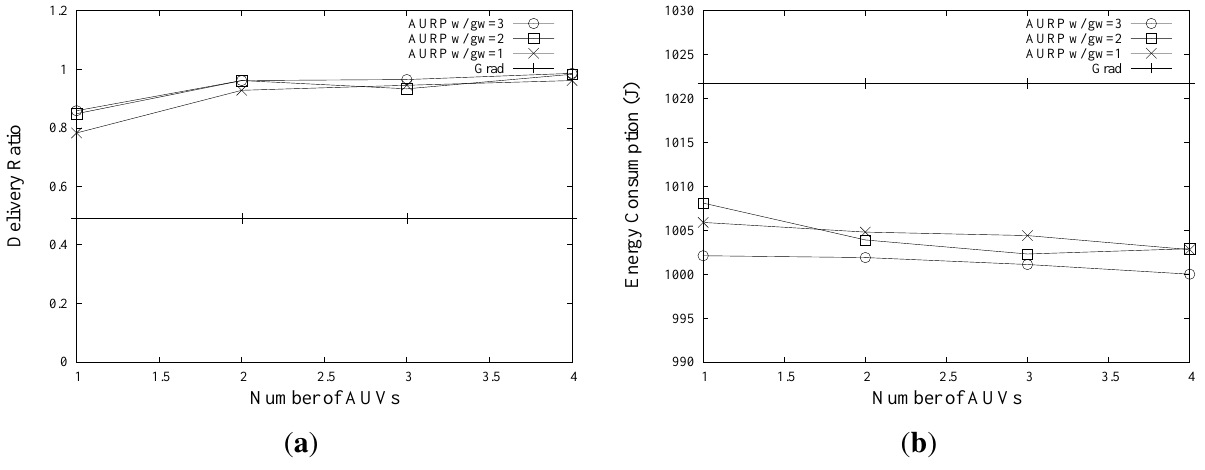
Figure 7. Effects of Number of AUVs on the network